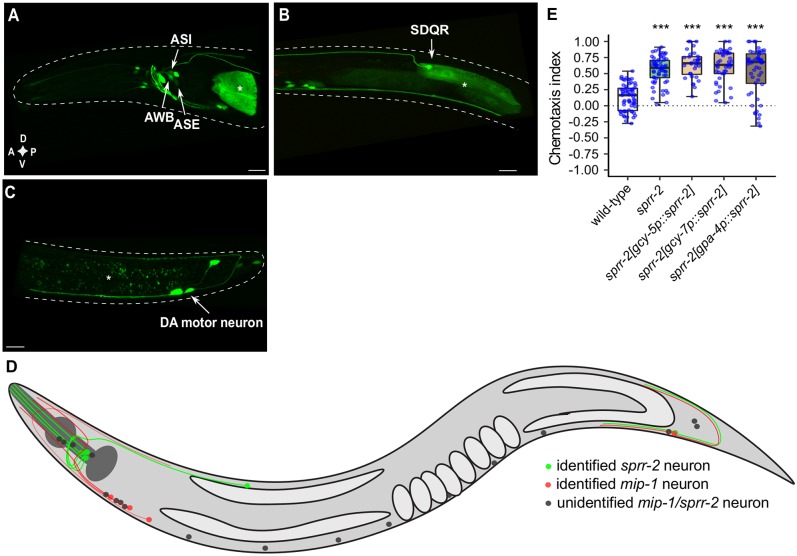
Expression pattern of the MIP receptor gene sprr-2.(A-C) Labeled confocal Z-stack projections showing expression of the sprr-2 fluorescent reporter transgene [sprr-2p::sprr-2::sl2::gfp] in adult hermaphrodites. Asterisk marks fluorescence in intestine resulting from the co-injection marker elt-2p::mCherry. Scale bars, 15 μm. (A) sprr-2 is expressed in several head neurons (around 10 pairs) of which ASE was identified by crossing with an ASE marker strain OH4165 (S4A Fig). ASI and AWB sensory neurons were identified by DiI staining (S4B Fig). (B) Expression in SDQR along the midbody. (C) sprr-2 expression in the tail localizes to 3 neurons, one of which is a DA motor neuron, most likely DA8 or DA9. D, dorsal; V, ventral; A, anterior; P, posterior. (D) Schematic representation of the left lateral view of identified mip-1 (red) and sprr-2 neurons and their projections (green) as well as unidentified neurons (gray). (E) Cell-specific expression of sprr-2 in ASER [gcy-5p::sprr-2], ASEL [gcy-7p::sprr-2], or ASI [gpa-4p::sprr-2] does not rescue the gustatory plasticity defect of NaCl-conditioned sprr-2 mutant animals. Individual CIs are indicated as blue dots. Boxplots indicate 25th (lower boundary), 50th (line), and 75th (upper boundary) percentiles. Whiskers show minimum and maximum values. Statistical comparisons by one-way ANOVA and Tukey post-hoc test (n ≥ 12). ***p<0.001.